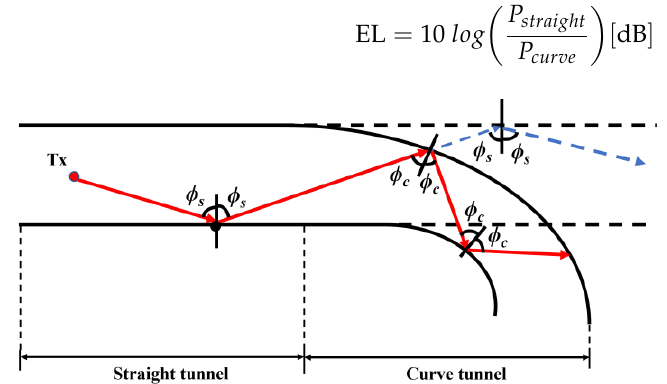
Figure 3. Schematic diagram of reflection in cascaded tunnel.